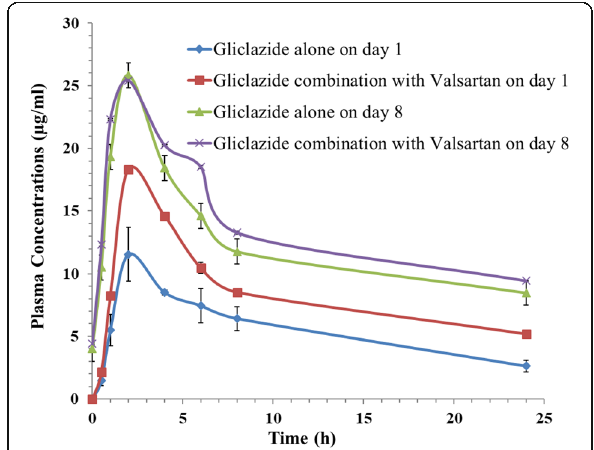
Fig. 6 Drug-drug interaction profile of gliclazide and valsartan (n = 6). Mean plasma concentrations ( μ g.ml − 1 )